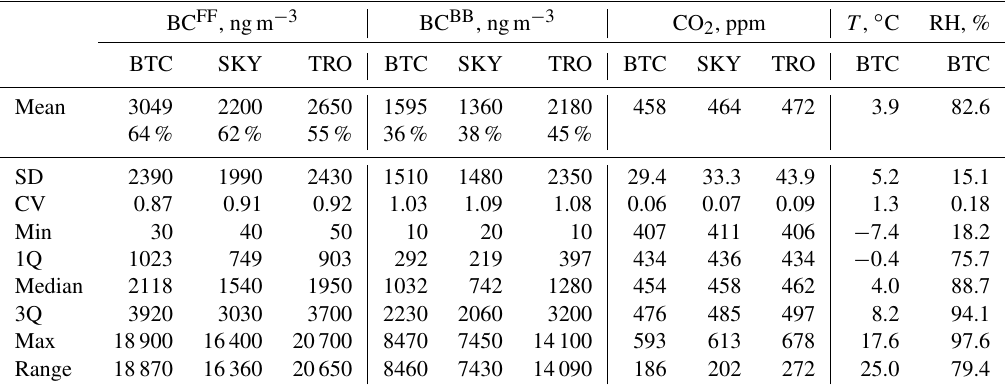
Table 2. Statistical metrics of the measurements at the three monitoring locations. Mean (with the source-specific percental share with respect to the total BC), standard deviation (SD), their ratio (coefficient of variation, CV), the three quartiles (1Q, “Median”, 3Q), minimum and maximum values as well as their difference (“Range”) were calculated from the FF- and BB-related BC and CO 2 concentrations. Statistical values for the temperature ( T ) and relative humidity (RH) were given as well for the BTC locations